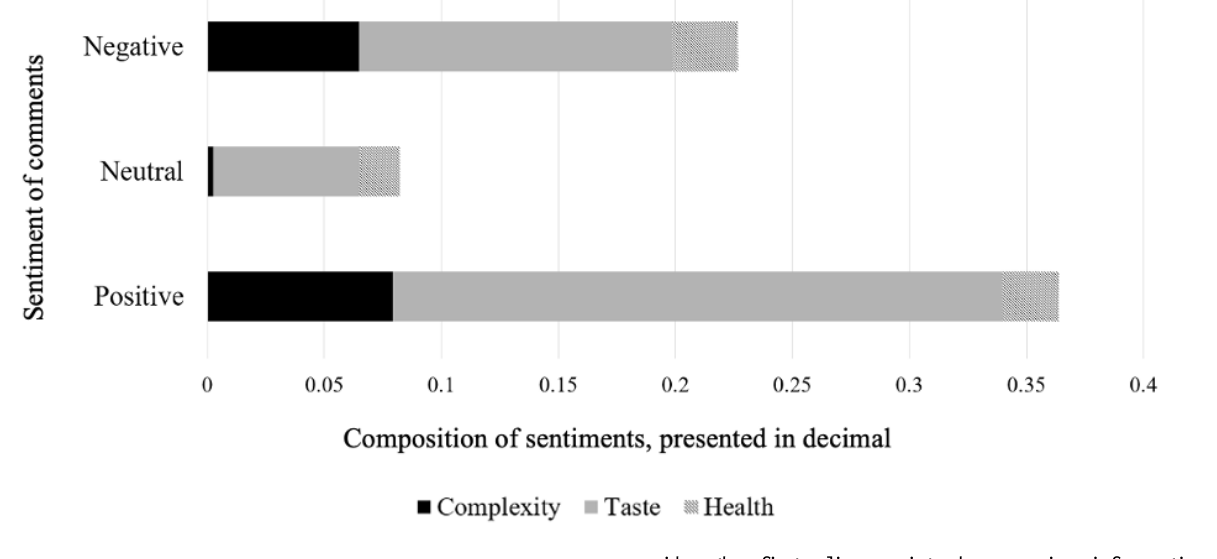
Figure 2. Pinterest users’attitudes toward different aspects of